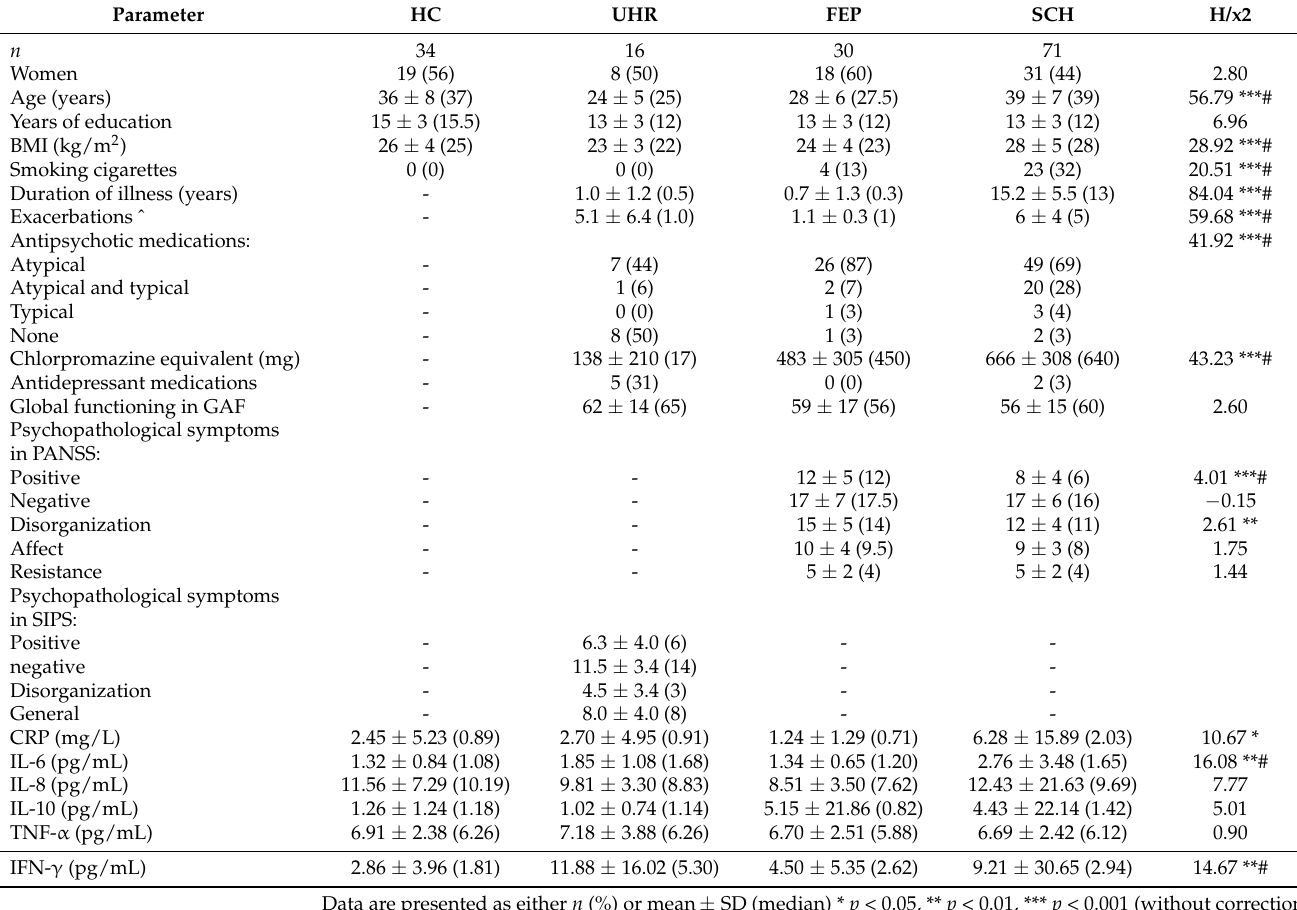
Table 1. Demographic, anthropometric, and clinical data for patients and controls.